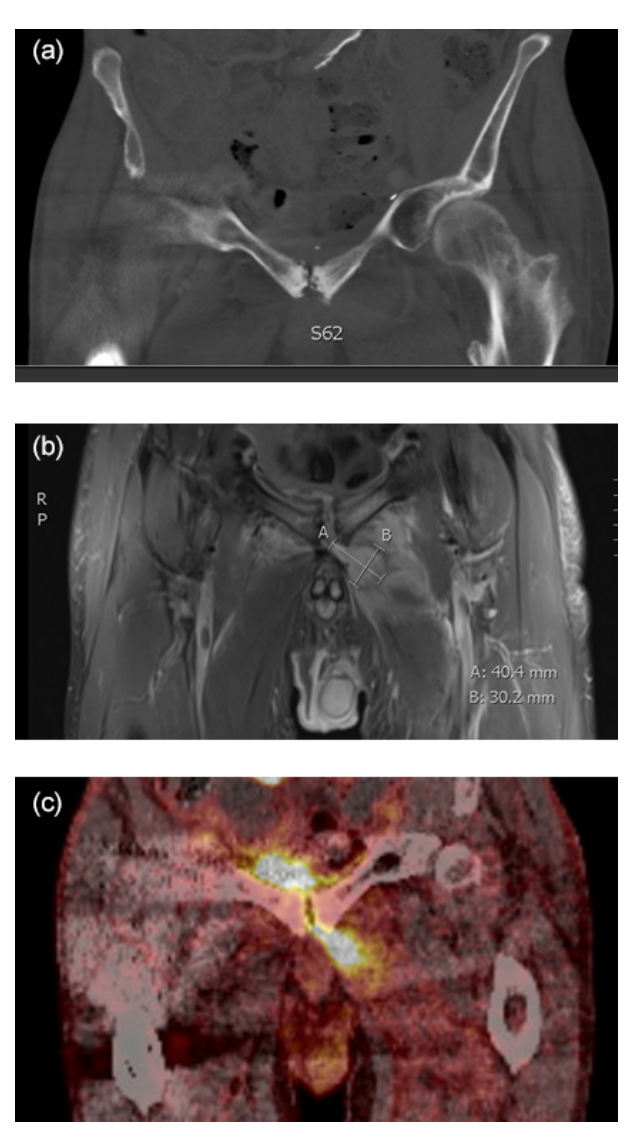
Figure 2. Example of three coronal diagnostic images before surgery from the same patient suggesting SAS diagnosis. (a) CT scan displaying osseous destruction in the symphysis. (b) MRI dis- playing an intramuscular abscess left to the symphysis. (c) PET/CT with increased FDG uptake in the symphysis and adjacent